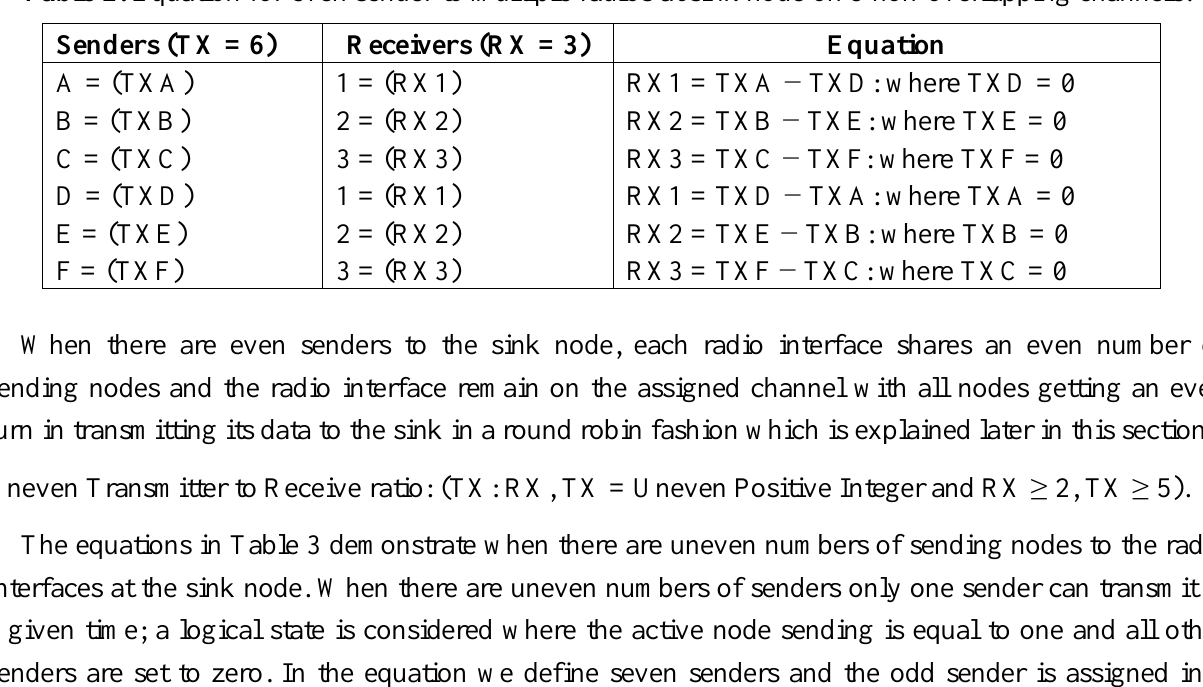
Table 2. Equation for even sender to multiple radios at sink node on 3 non-overlapping channels.